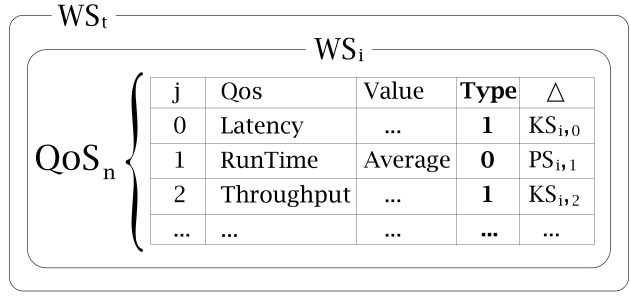
Figure 6. WS specification and recognition